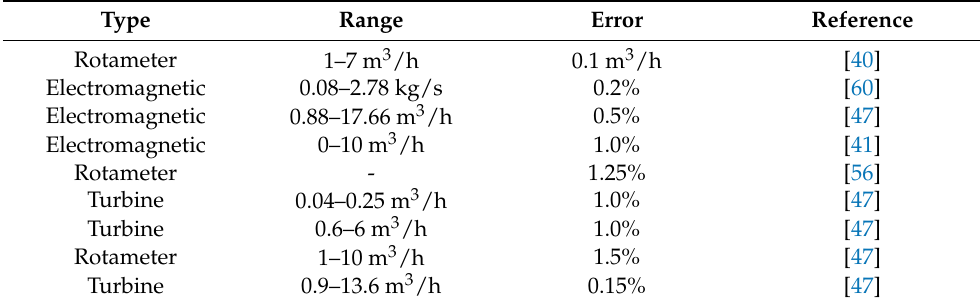
Table 18. Devices used in water flow measurements.